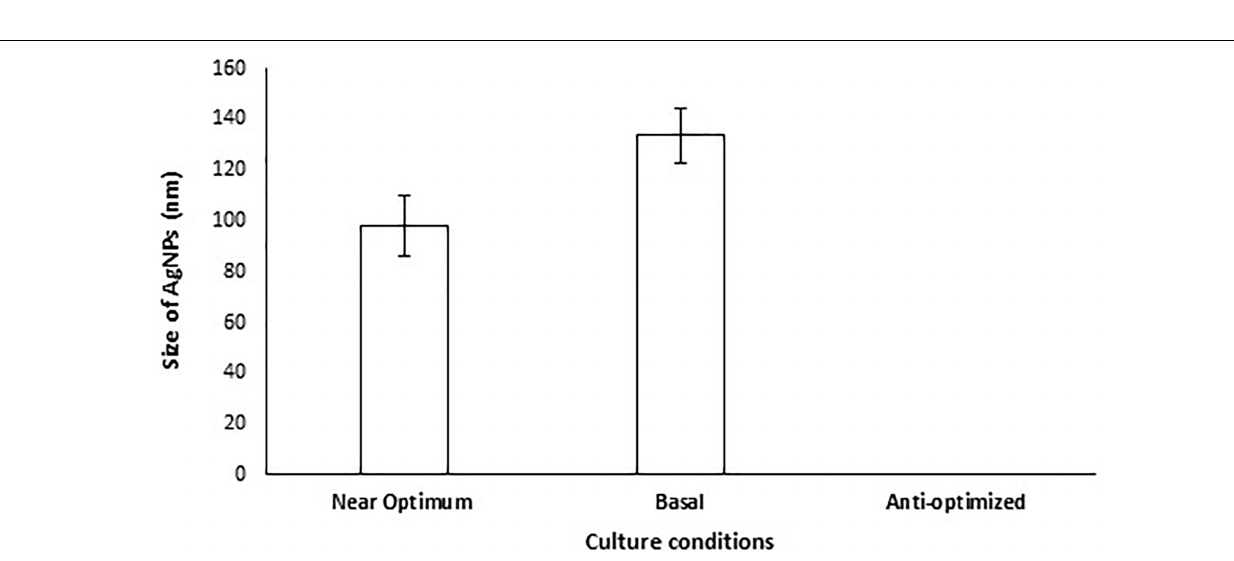
Frontiers in Bioengineering and Biotechnology |